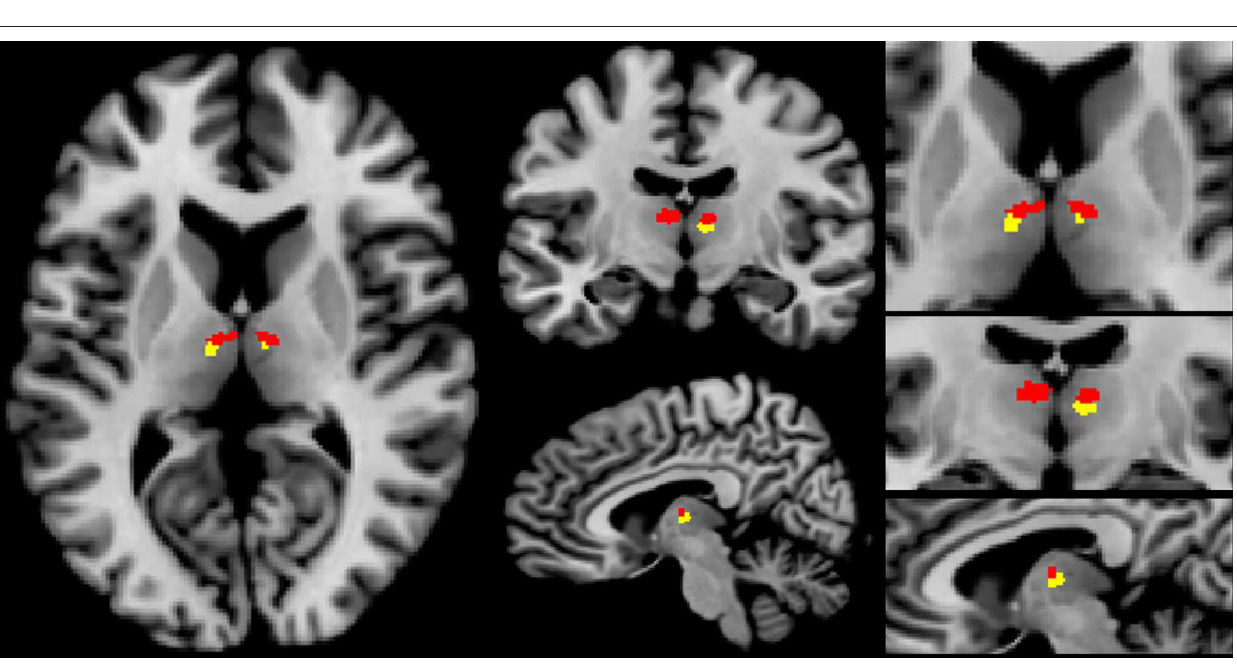
FIguRe 6 | Thalamic activation for erotic and emotional picture perception in the bilateral mediodorsal thalamic nucleus. Erotic picture perception showed a more mediodorsal activation pattern (red voxels), while activation for emotional picture perception was located more laterally (yellow voxels) ( p < 0.001, uncorrected, x : − 7, y : − 13, z :